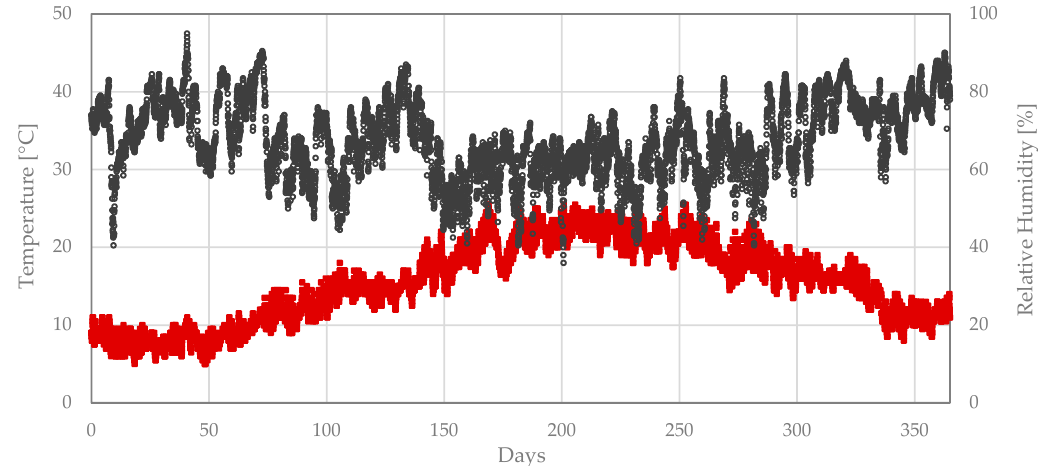
Figure 2. Average temperature and relative humidity values measured inside the church.